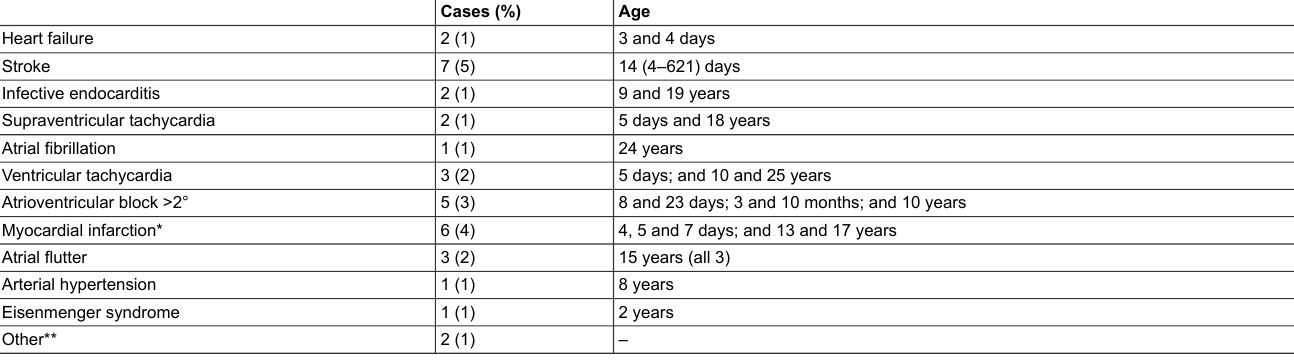
Table S1: Number of previous cardiac-related complications and interventions until